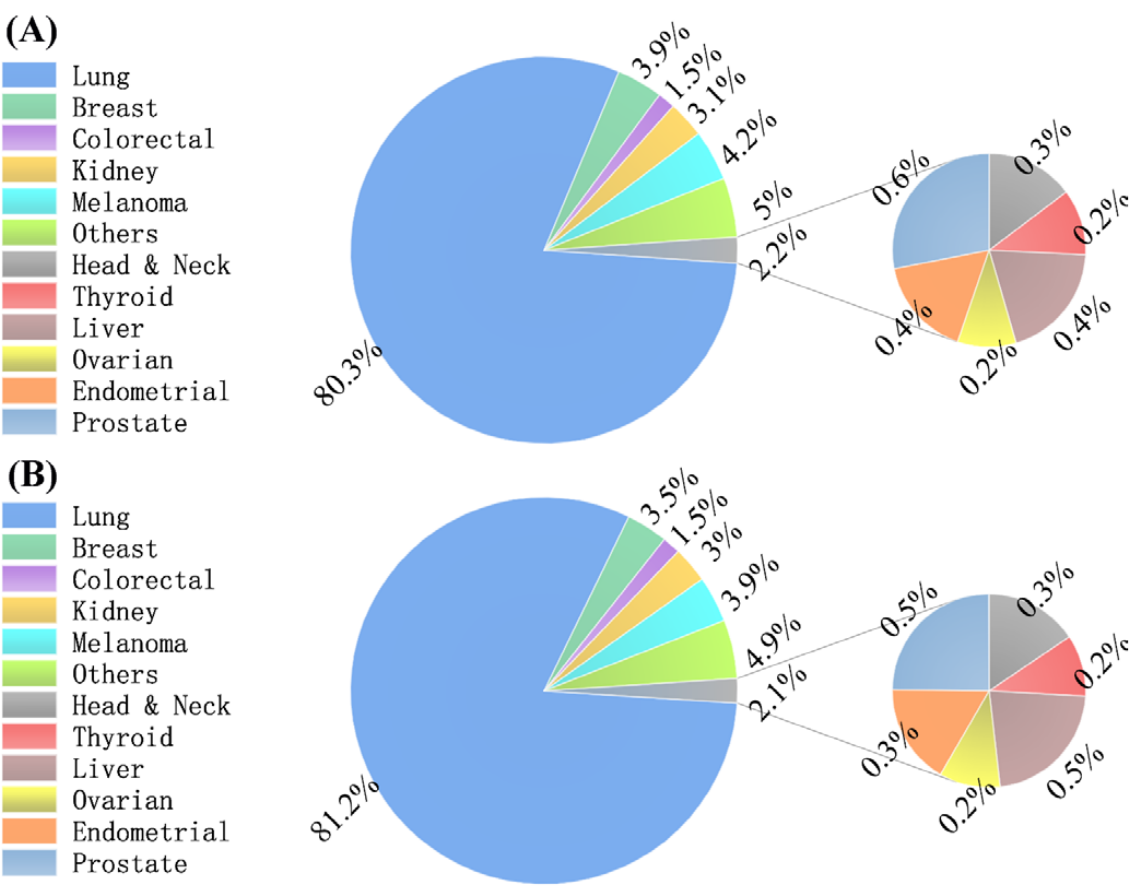
Figure 1. Distribution of primary cancer in patients with synchronous brain metastases in incidence analyses ( A ) and mortality analyses ( B ).